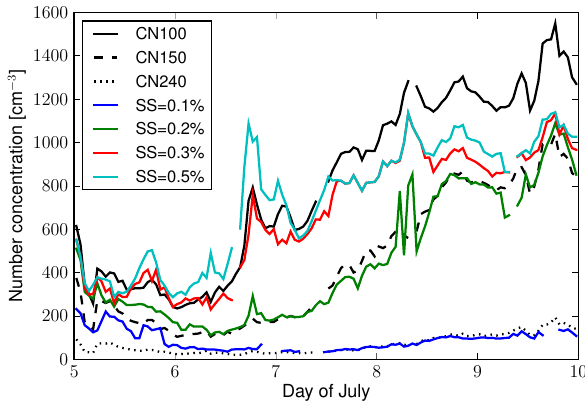
Fig. 11. Size-resolved sulfate and organic signal from the AMS at Raven’s Nest for the morning of 7 July and the evening of 8 July. The x-axis represents geometric diameter (converted from vacuum aerodynamic diameter assuming a density of 1300kgm − 3 ) . The average deviation in the PToF signal across the size distribution is approximately 0.0019Hz, which implies that changes in organics throughout the entire size range and sulfate from 100–600nm may be reliably detected (at least qualitatively). Organics have increased in size and in total mass. The total mass of sulfate has remained essentially constant, but it has grown to larger sizes due to conden- sation of organics. While there was sulfate signal for 100–150nm particles above the detection limit during the early time, there was no significant sulfate signal in this size range during the later time. The timing of this shift in sulfate sizes corresponds to the lowering of kappa in the 100-nm